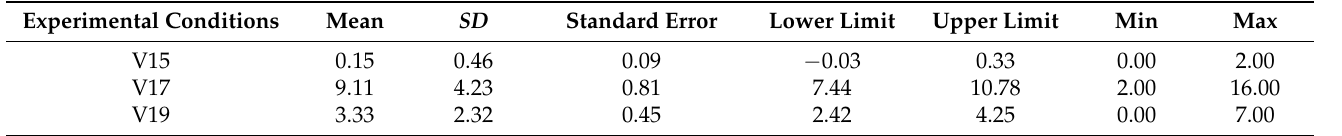
Figure 14. Number of crashed cars.